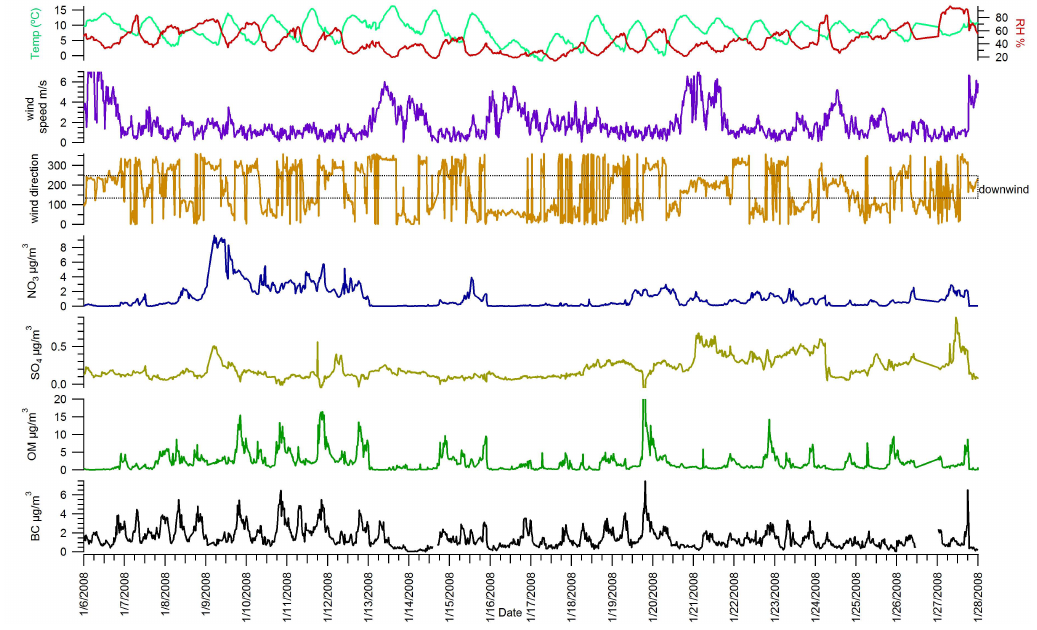
Fig. 3. Time series of temperature (degrees C), relative humidity (%), wind speed (ms − 1 ), wind direction, AMS nitrate ( µ g/m 3 ), AMS sulfate (µgm − 3 ), AMS OM (µgm − 3 ), and Aethalometer BC (µgm − 3 ). Major tick marks indicate midnight for each day. Periods during which the monitoring site is downwind of the freeway are indicated by the dashed rectangle on the wind direction time series.